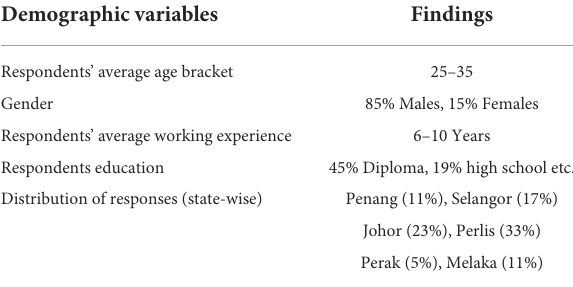
TABLE 1 Demographic information of the